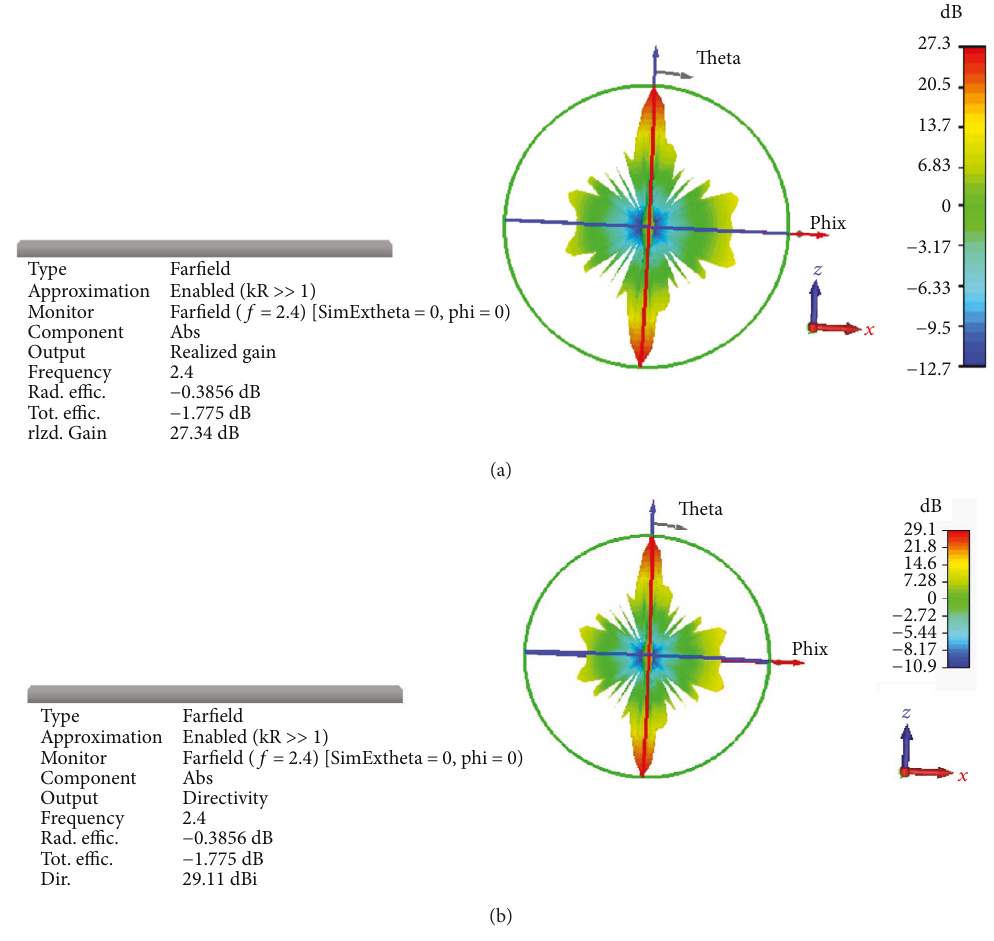
Figure 8: (a) 3D model of the radiation pattern of the gain. (b) 3D model of the radiation pattern of the